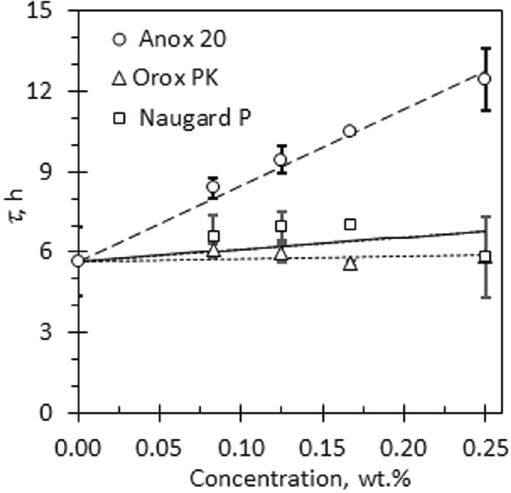
Figure 3. Variation of time constant τ with neat antioxidant concentration. Error bars indicate ± 3 standard deviations.